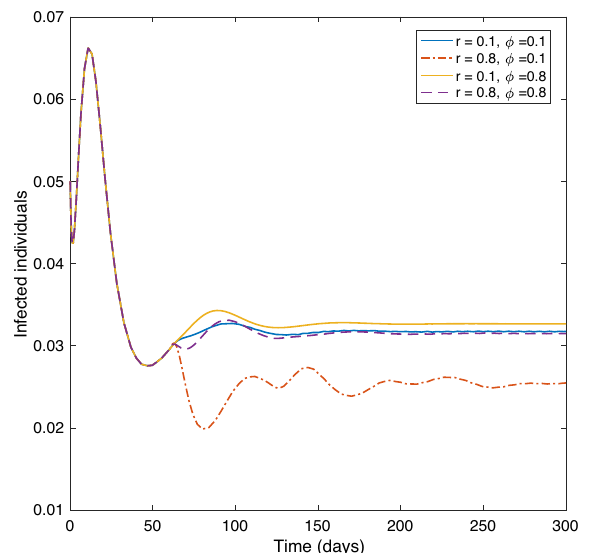
Figure 7. The effect of r and φ on the infected class of system (25).